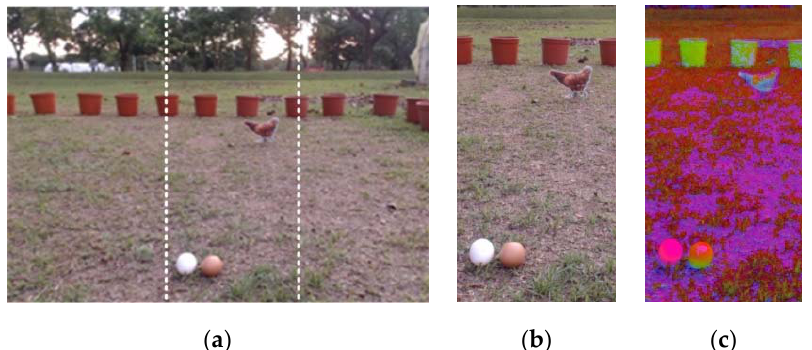
Figure 2. The egg recognition process: ( a ) original image; ( b ) screenshot of the central area in the image; ( c ) image after color transformation.